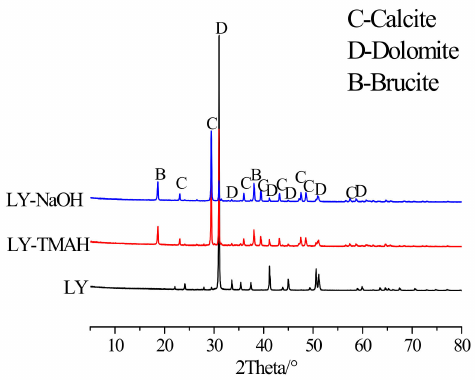
Figure 7. XRD patterns of untreated dolomite powdered and dolomite powdered compacted bodies in 1 mol / L NaOH and TMAH solutions at 60 ◦ C for 55 days.